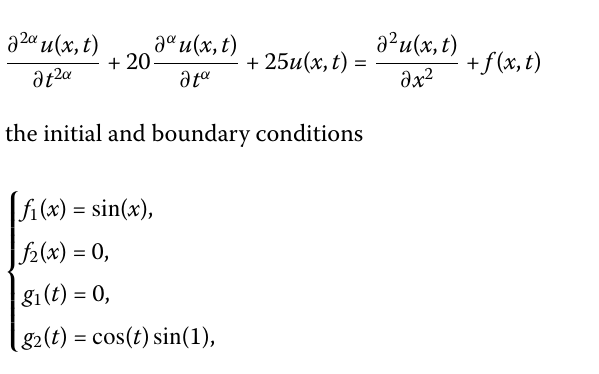
problems can be visualized in Fig. 2. Compatibility of exact and approximated solution for Problem 1 and Problem 2 can be viewed in Fig. 3 and Fig. 4,